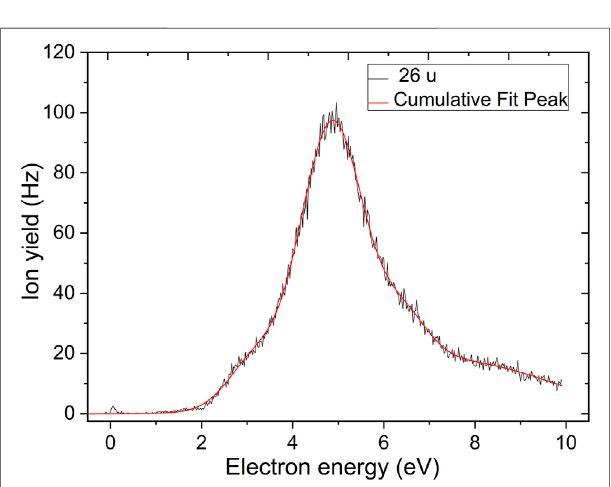
FIGURE 5 | Anion ef fi ciency curve for CN − formed upon electron attachment to TMZ.